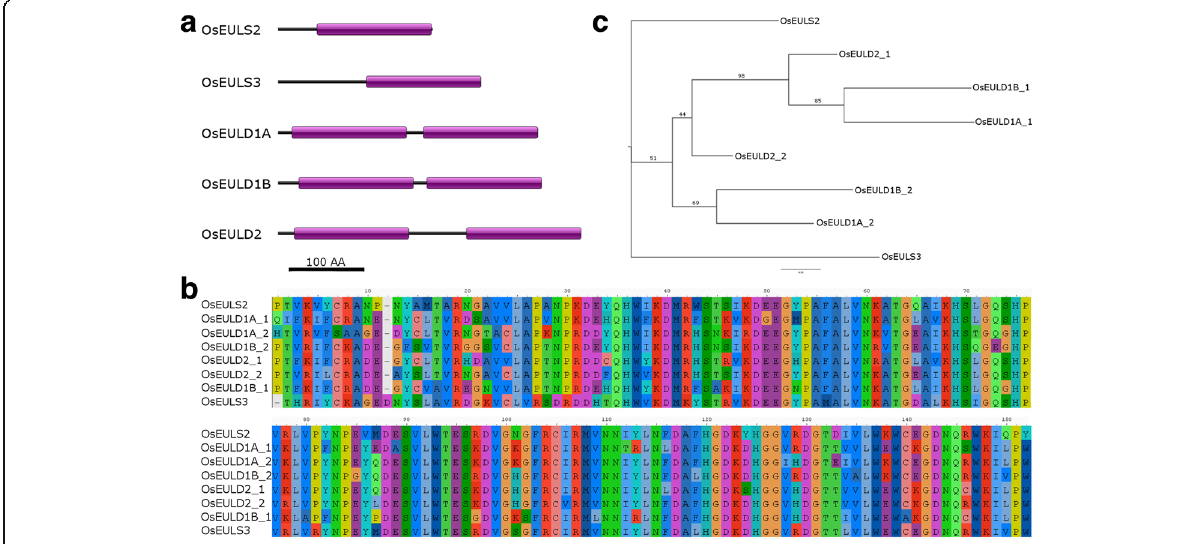
Fig. 2 Sequence comparison of EUL homologs from O. sativa at protein level. a . Domain organization of the rice EULs. The EUL domains are represented by a purple bar. b . Sequence alignment of the different EUL domains. c . Phylogenetic relationship of EUL domains. A phylogenetic tree was generated by RaxML based on the sequence alignment shown in panel ( b ). Branch labels show bootstrapping